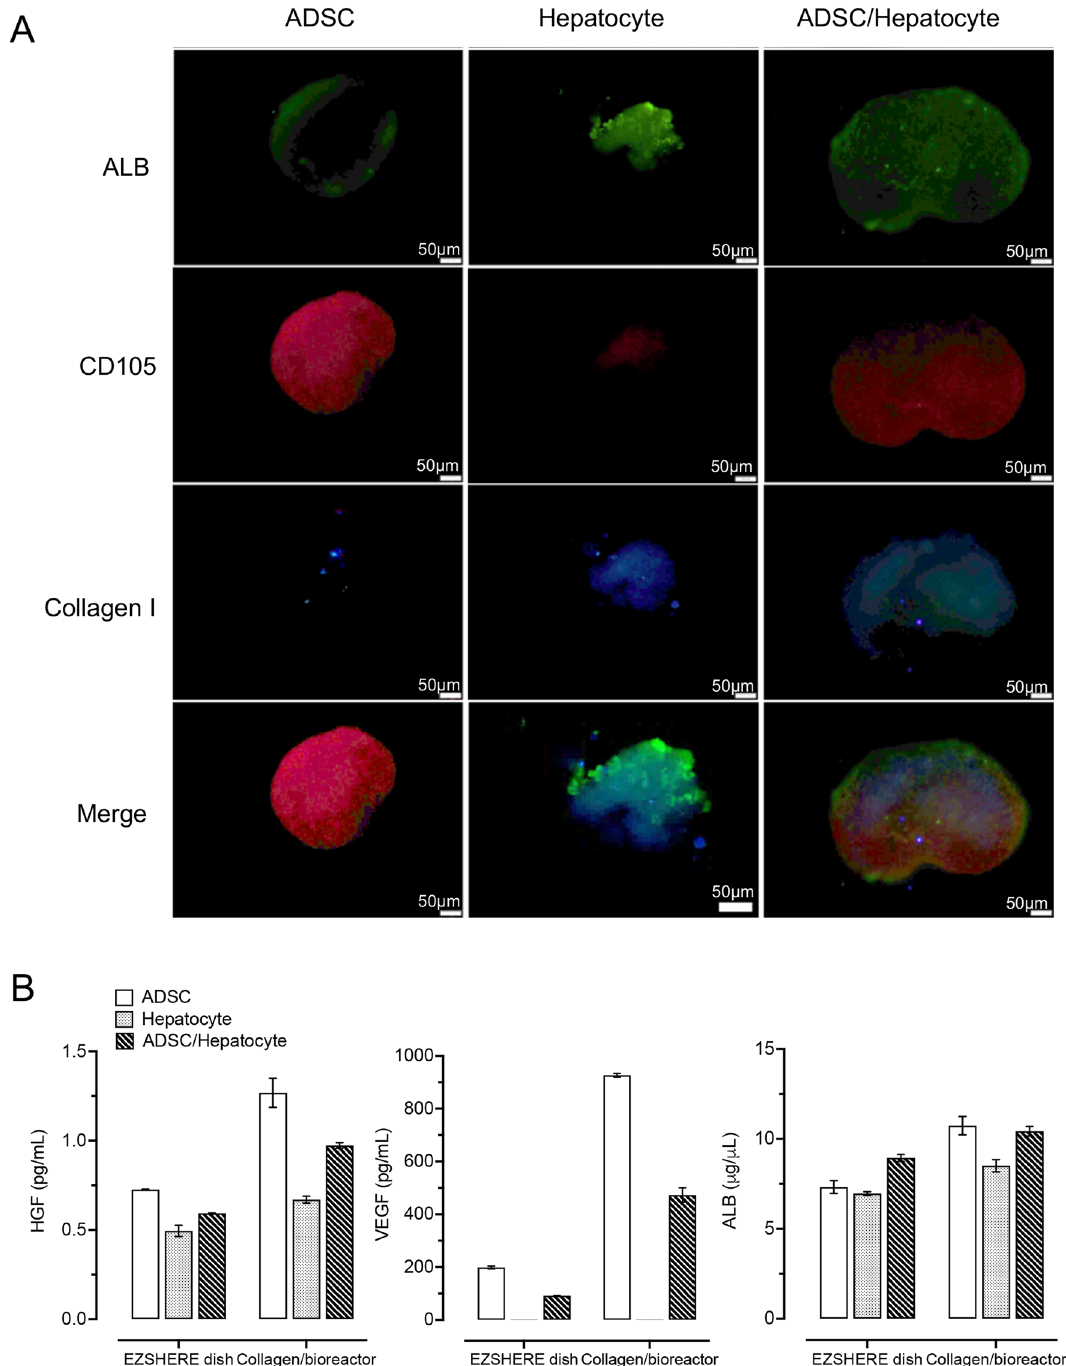
Figure 2. ( A ) Fluorescence images of spheroids. Albumin (hepatocyte marker, green), collagen I (hepatocyte marker, blue) and CD105 (ADSC marker, red) were visualized at the 3 days of culture. Scale bar: 50 μm. ( B ) Hepatic growth factor (HGF), vascular endothelial growth factor (VEGF) and albumin secreted by adipose- derived stem cell (ADSC) and hepatocyte spheroids produced by the collagen fiber/bioreactor-based approach and EZSHERE dish (2-day culture). Group data are shown as means ±